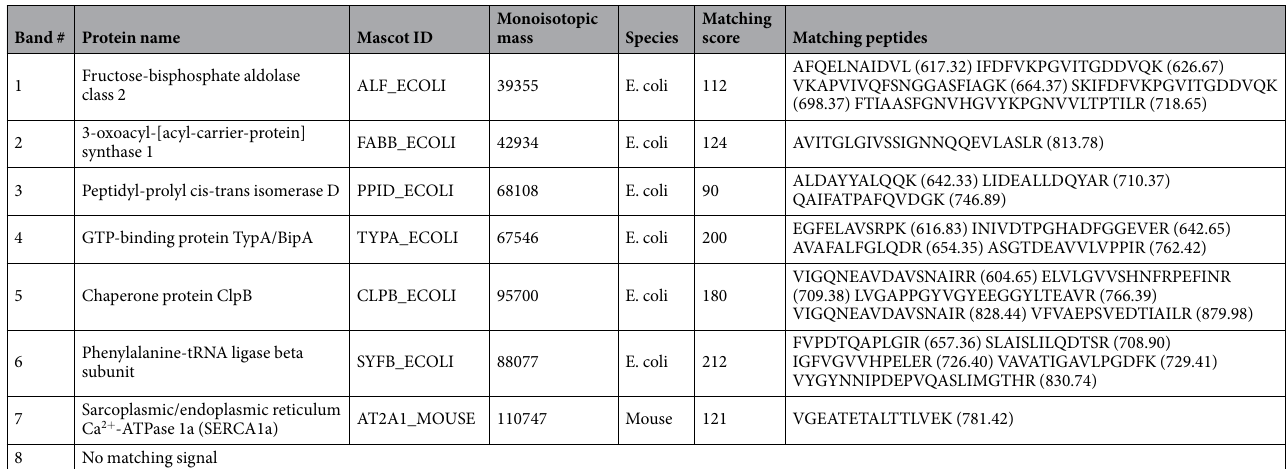
Table 1. List of proteins identified by qTOF-MS.